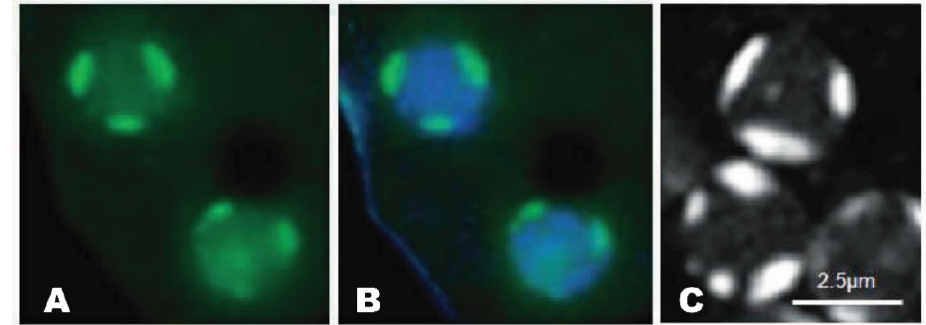
Figure 1. Nucleolar patches of Dictyostelium . A . GFP-NumA1 (green) localization. B . GFP-NumA1 localization with DNA (Hoescht, blue staining) stained. C . FITC-NumA1-NLS1 localization (white patches).